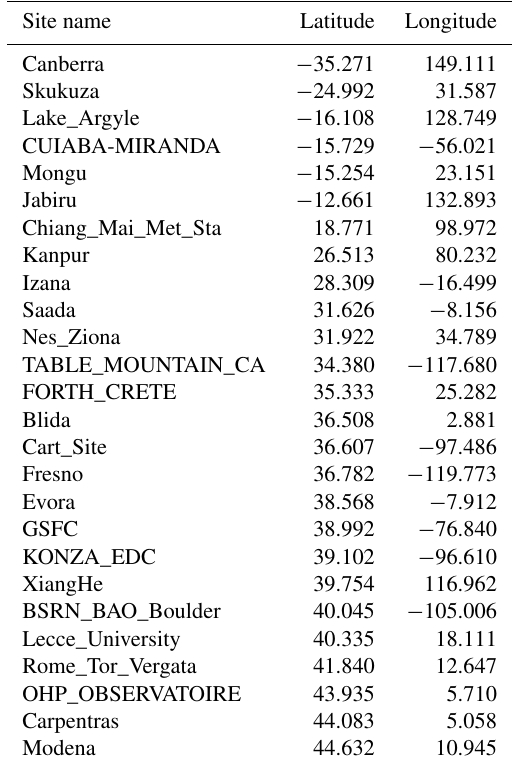
Table 3. List of selected AERONET stations for the long-term anal- ysis as presented in Fig.